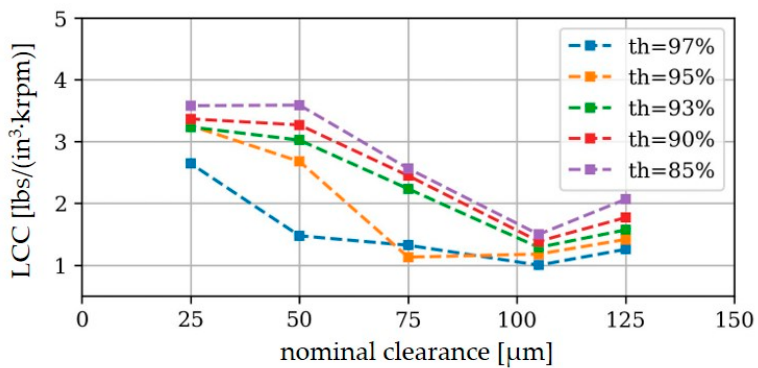
Figure 10. Load capacity coefficients (LCC) for different fallback threshold levels used for lift-off detection (blue: threshold level 97%), (yellow: threshold level 95%), (green: threshold level 93%), (red: threshold level 90%), (purple: threshold level 85%); (1 krpm = (100/3)π ⋅ rad/s).